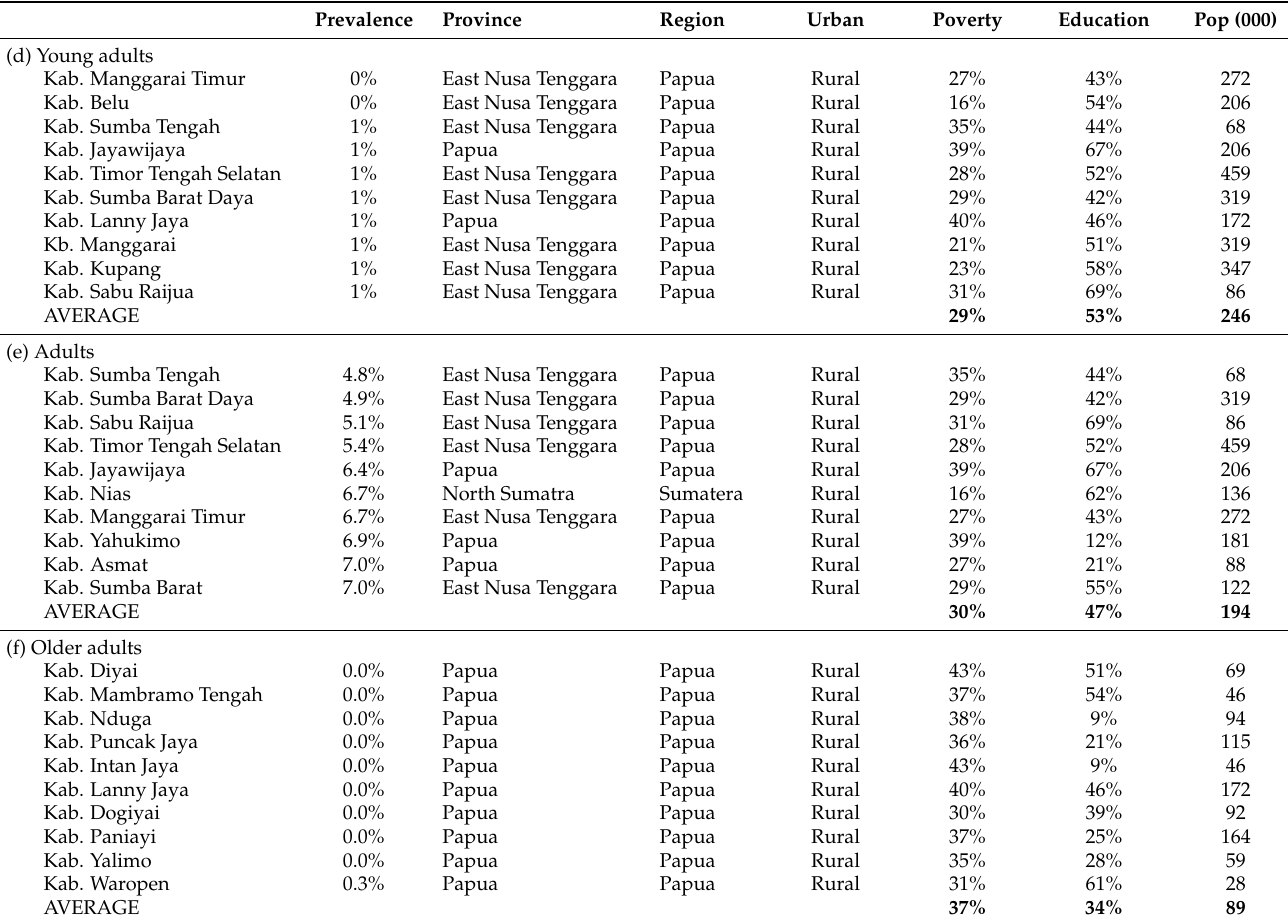
Prevalence Province Region Urban Poverty Education